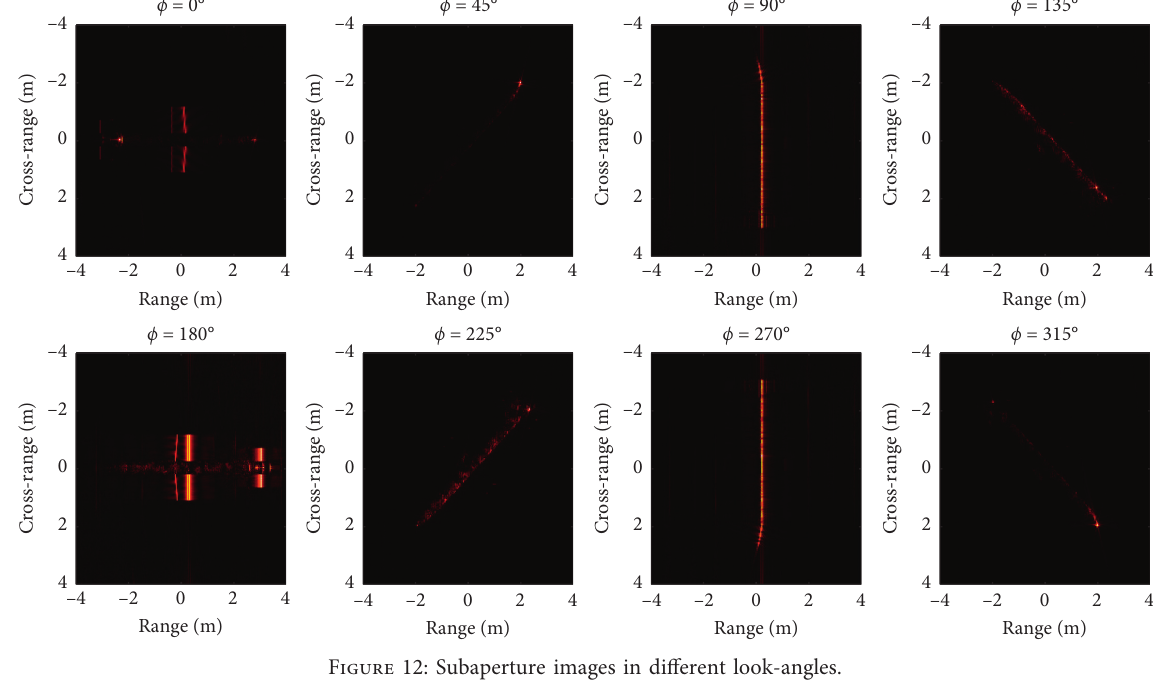
Figure 12: Subaperture images in different look-angles.